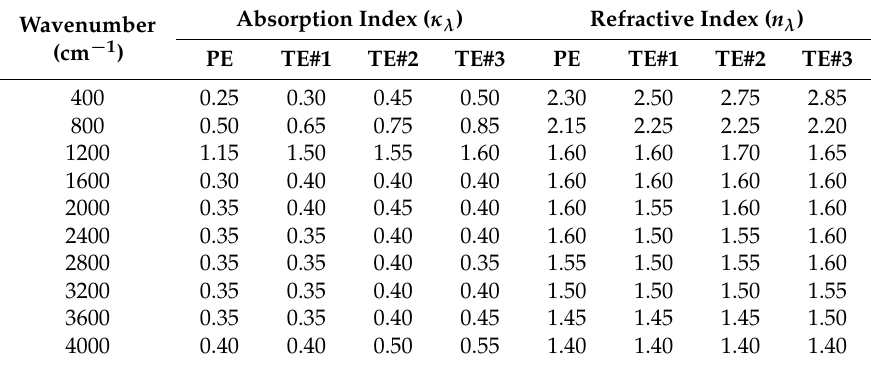
Table 1. κ λ and n λ of PE and TE#1–TE#3 at 400–4000 cm − 1